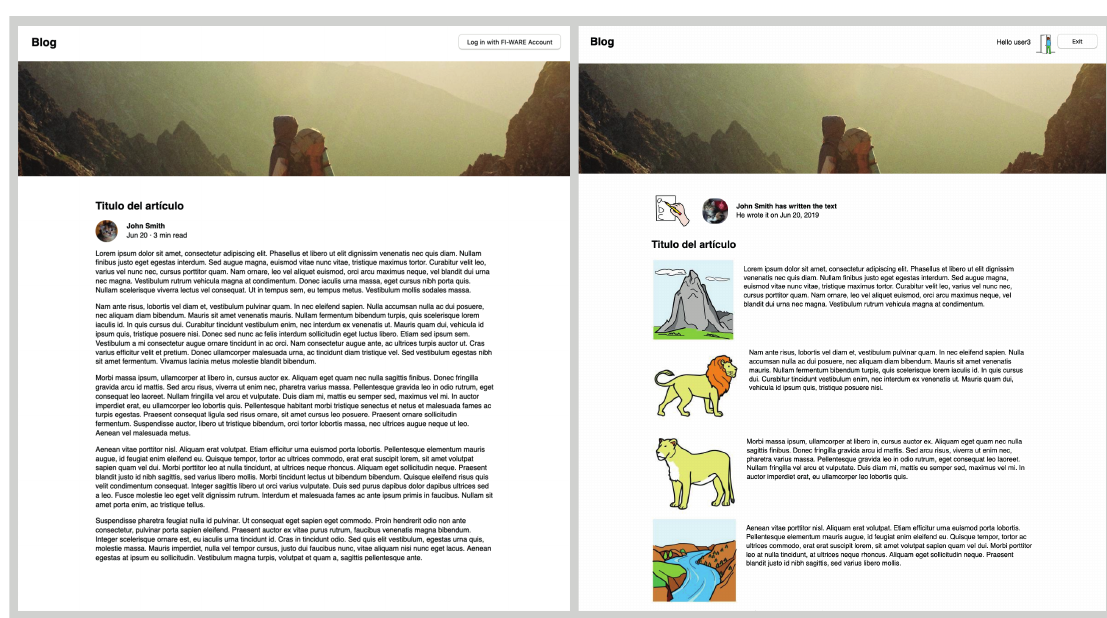
Figure 8. Interface 3. Voice User Interface suggestion.